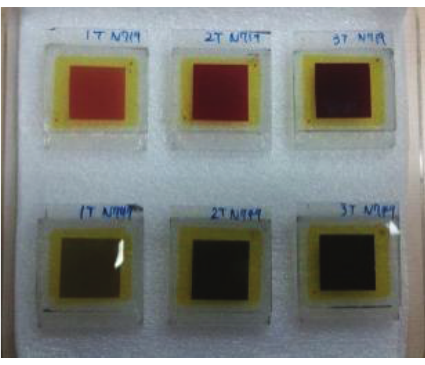
Figure 3: DSCs with different dye and thickness.